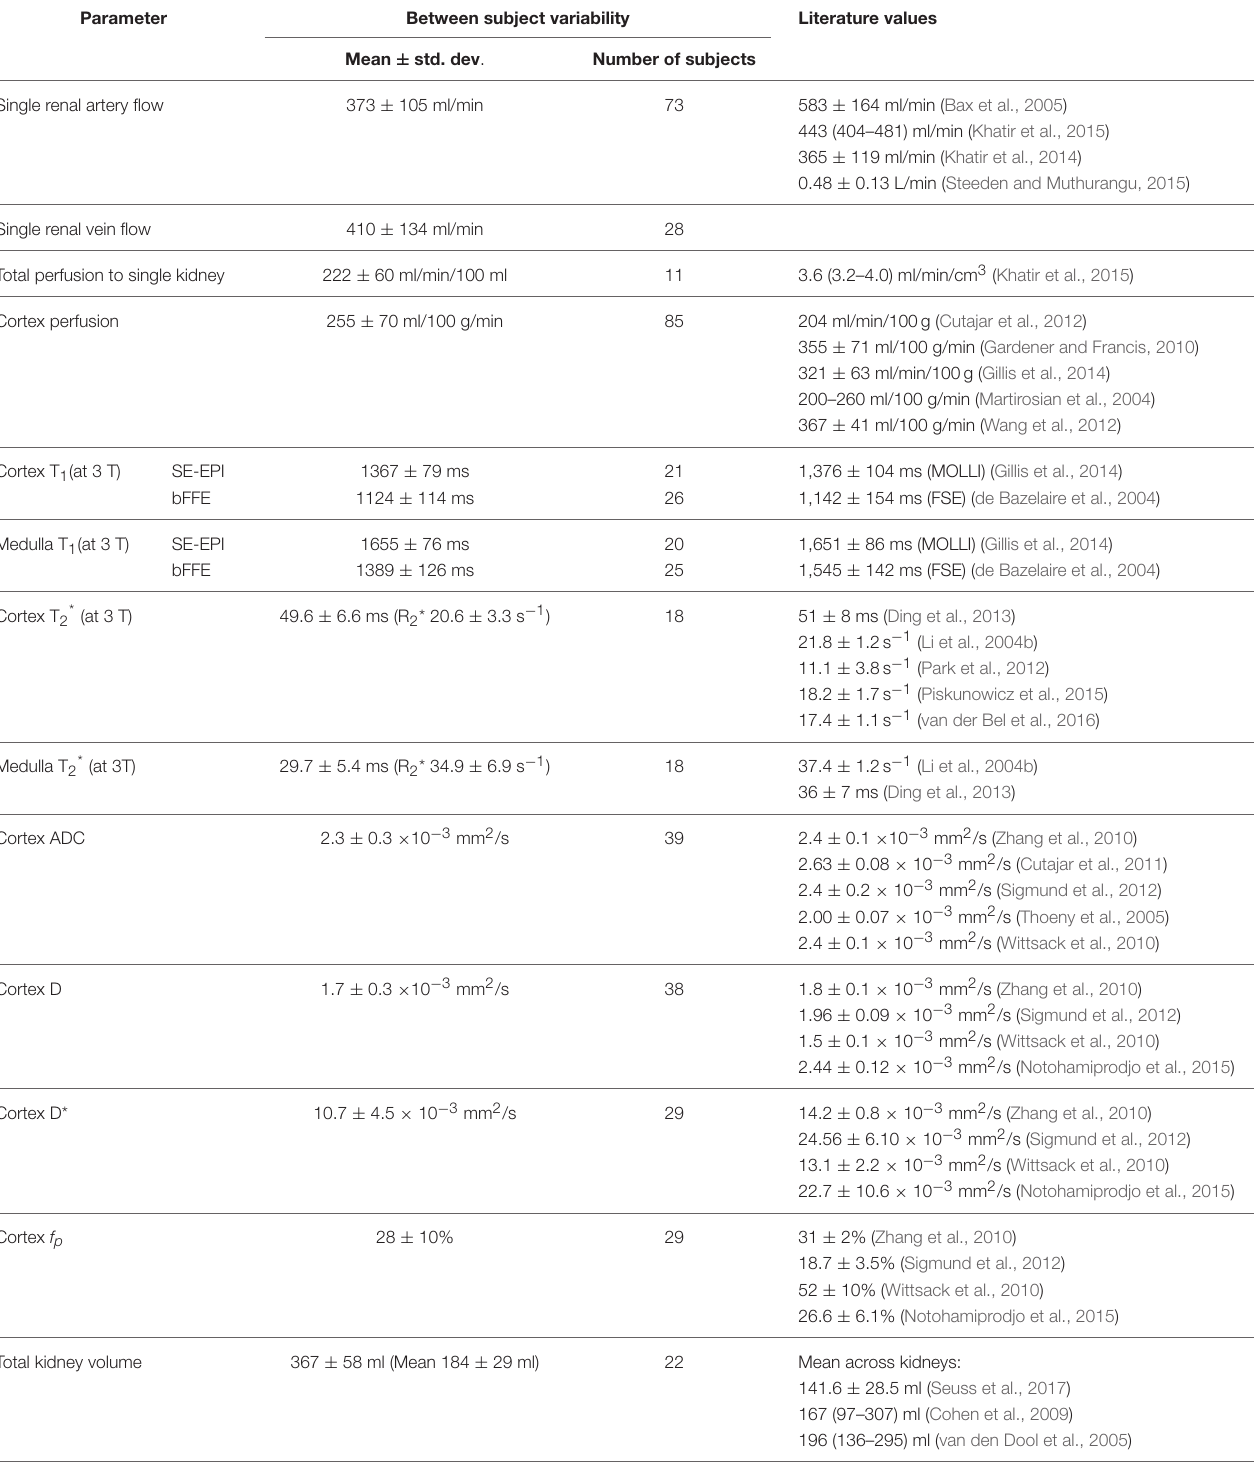
TABLE 1 | Between-subject variability for multiparametric MRI measures in healthy participants and associated literature values. Parameter Between subject variability Mean ± std. dev